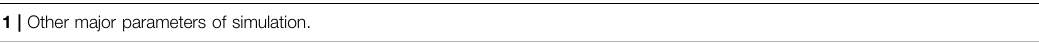
TABLE 1 | Other major parameters of simulation. Parameters Value Unit